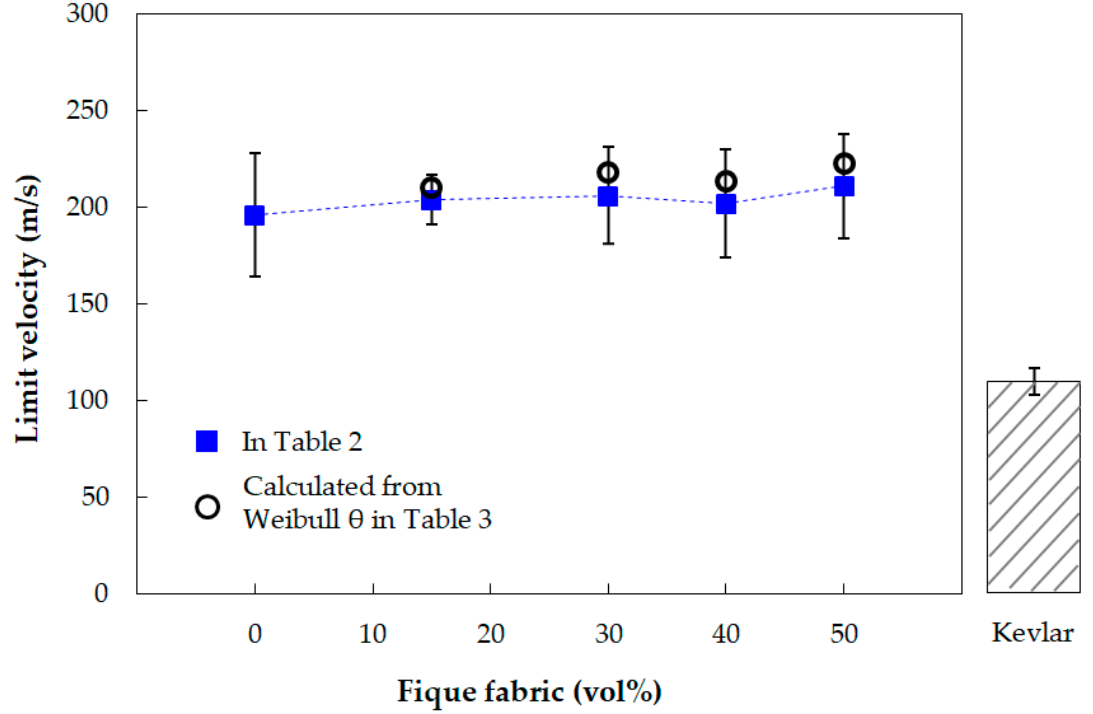
Figure 7. Variation of (cid:1848) (cid:3013) with the volume fraction of fique fabric from values in Table 2 and calculated from Weibull θ in Table 3. Reported (cid:1848) (cid:3013) value for Kevlar TM indicated in adjacent bar [24].